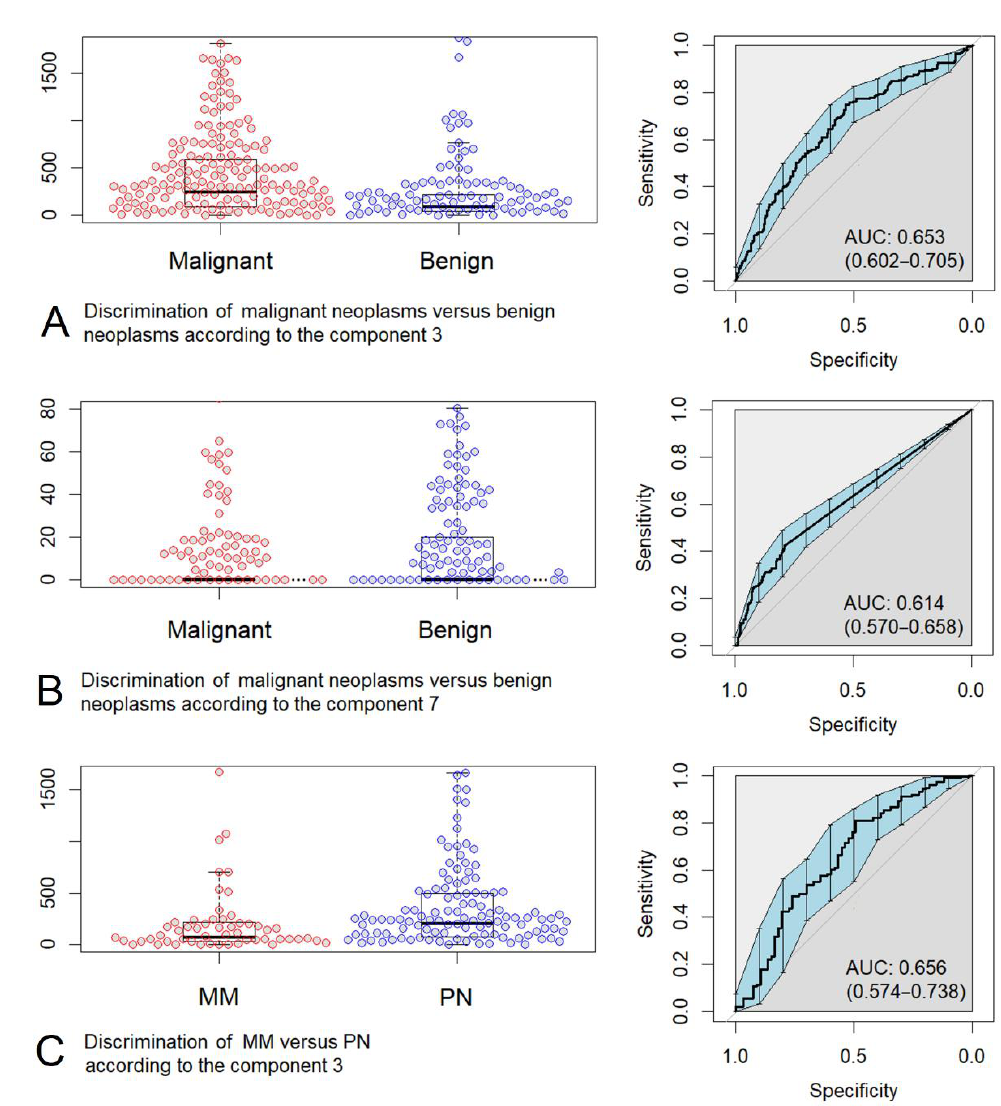
Figure 7. Box-plot diagrams and ROC curves corresponding to several cases of discrimination: ( A ) malignant neoplasms (basal cell carcinoma + malignant melanoma) versus benign neoplasms (keratosis + pigmented nevus) according to the MCR Component 3 (proteins), ( B ) malignant neoplasms (basal cell carcinoma + malignant melanoma) versus benign neoplasms (keratosis + pigmented nevus) according to the MCR Component 7 (proteins, lipids, nature moisturizing factor, melanin), ( C ) malignant melanoma (MM) versus pigmented nevus (PN) according to the MCR Component 3 (proteins).